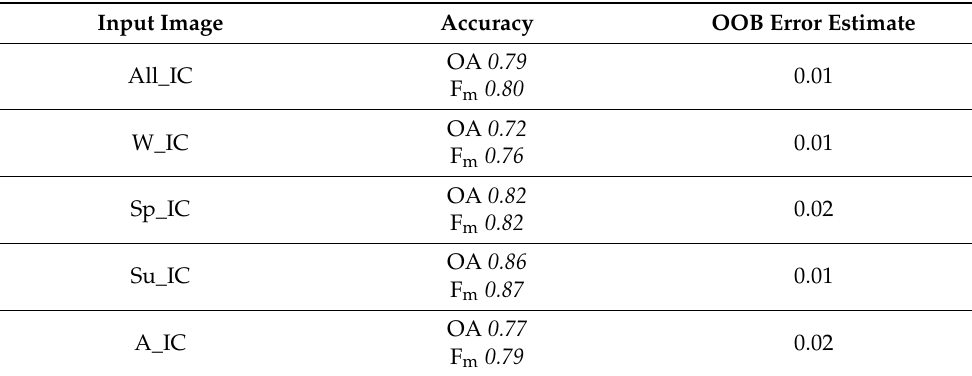
Table 3. The different combinations of image composites (ICs) tested in the first step of the proposed method (i.e., best input image composite selection). The obtained overall accuracy (OA) and multi- class F-score (F m ) are reported for each tested IC. Moreover, the third column reports the out-of-bag (OOB) error estimate values for the random forest (RF) algorithm.